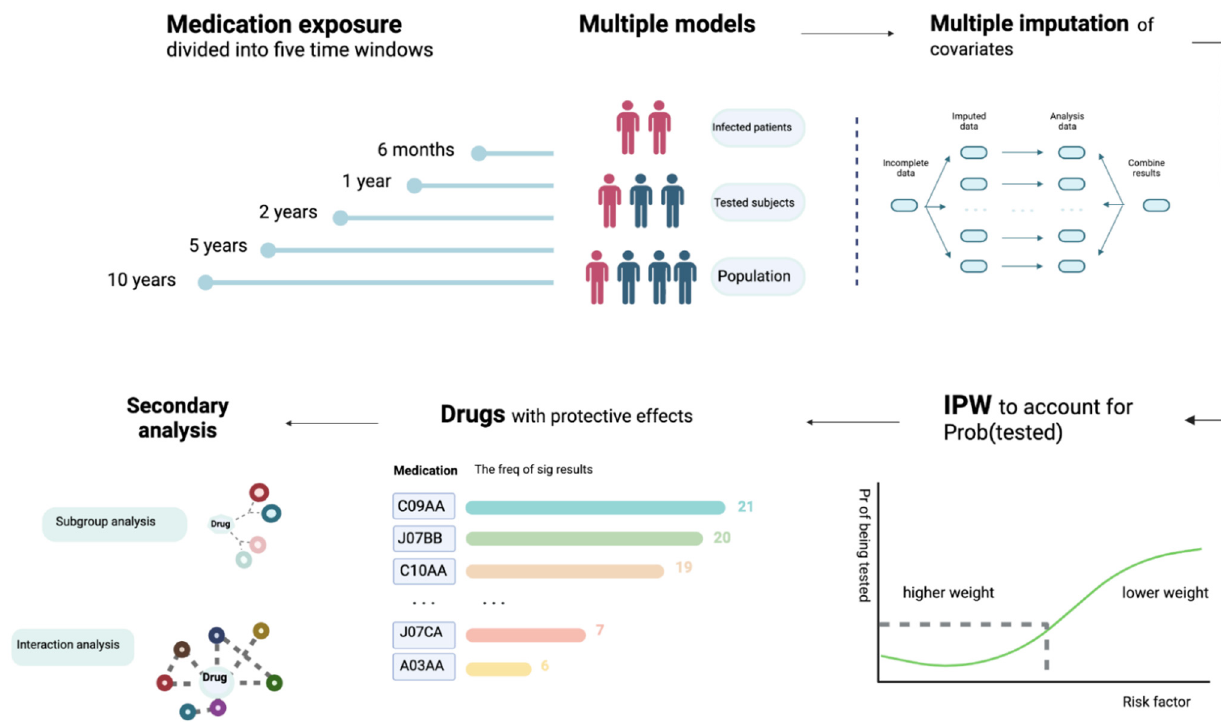
Figure 1. An overview of the analytic workflow. We considered five exposure time windows and multiple statistical models. We conducted analyses within infected patients, tested subjects, and the whole population, respectively. Effects of prescribed medications/vaccinations on the risk of infection, severity of disease (hospitalization as proxy) and mortality were investigated separately. Missing data were accounted for by multiple imputation. Inverse probability weighting (IPW) of the probability of being tested (Prob(tested)) was employed to reduce testing bias. Multivariable logistic regression was conducted, controlling for main confounders. We primarily focused on drugs with protective effects, as residual confounding tends to bias towards harmful effects. In addition, we performed further subgroup and interaction analysis to identify factors that may modify the drug effects.